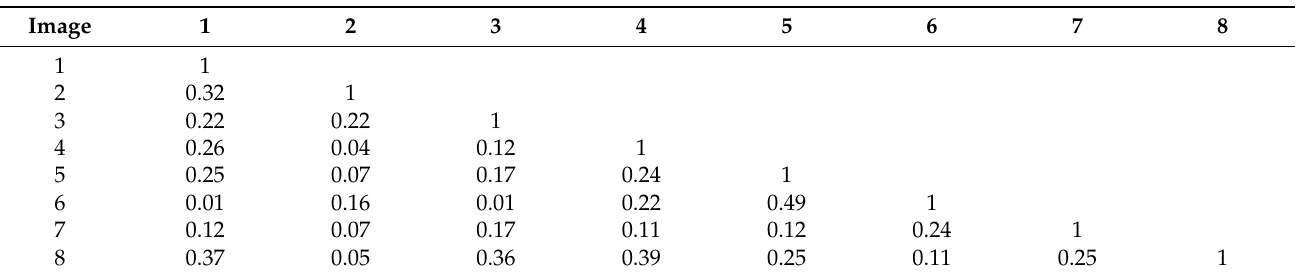
Figure 13. Encrypted medical images and extracted watermarks after some conventional attacks. Images after 13% attack of Gaussian noise and corresponding extracted watermarks ( a , b ), images after 5% attack of JPEG compression and corresponding extracted watermarks ( c , d ), and images after 10 attacks of median filtering [7 × 7] and corresponding extracted watermarks ( e , f ). Table 3. Experimental data under conventional attack. Attacks